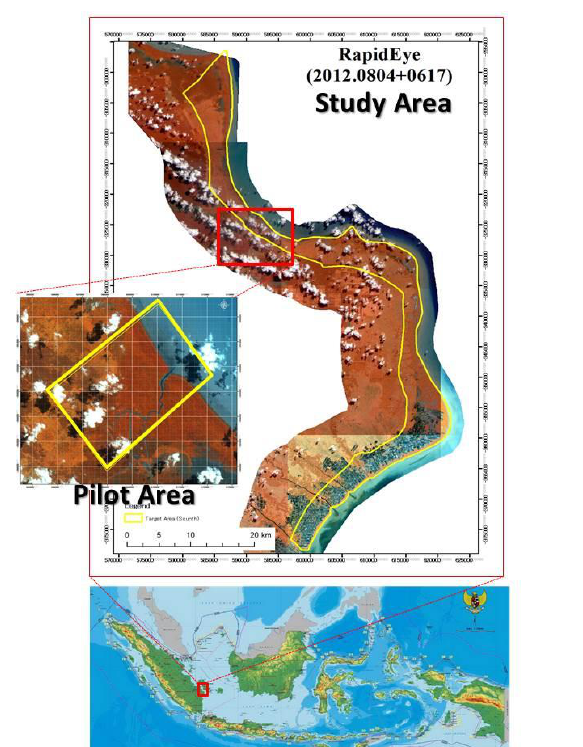
Figure 1. Study area and pilot